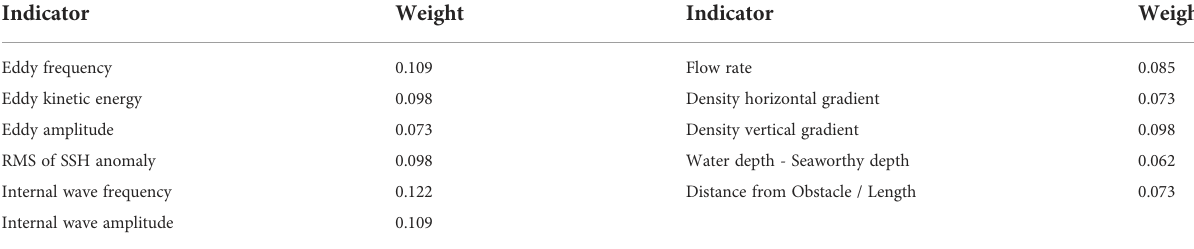
TABLE 4 The weights of assessment indicators.